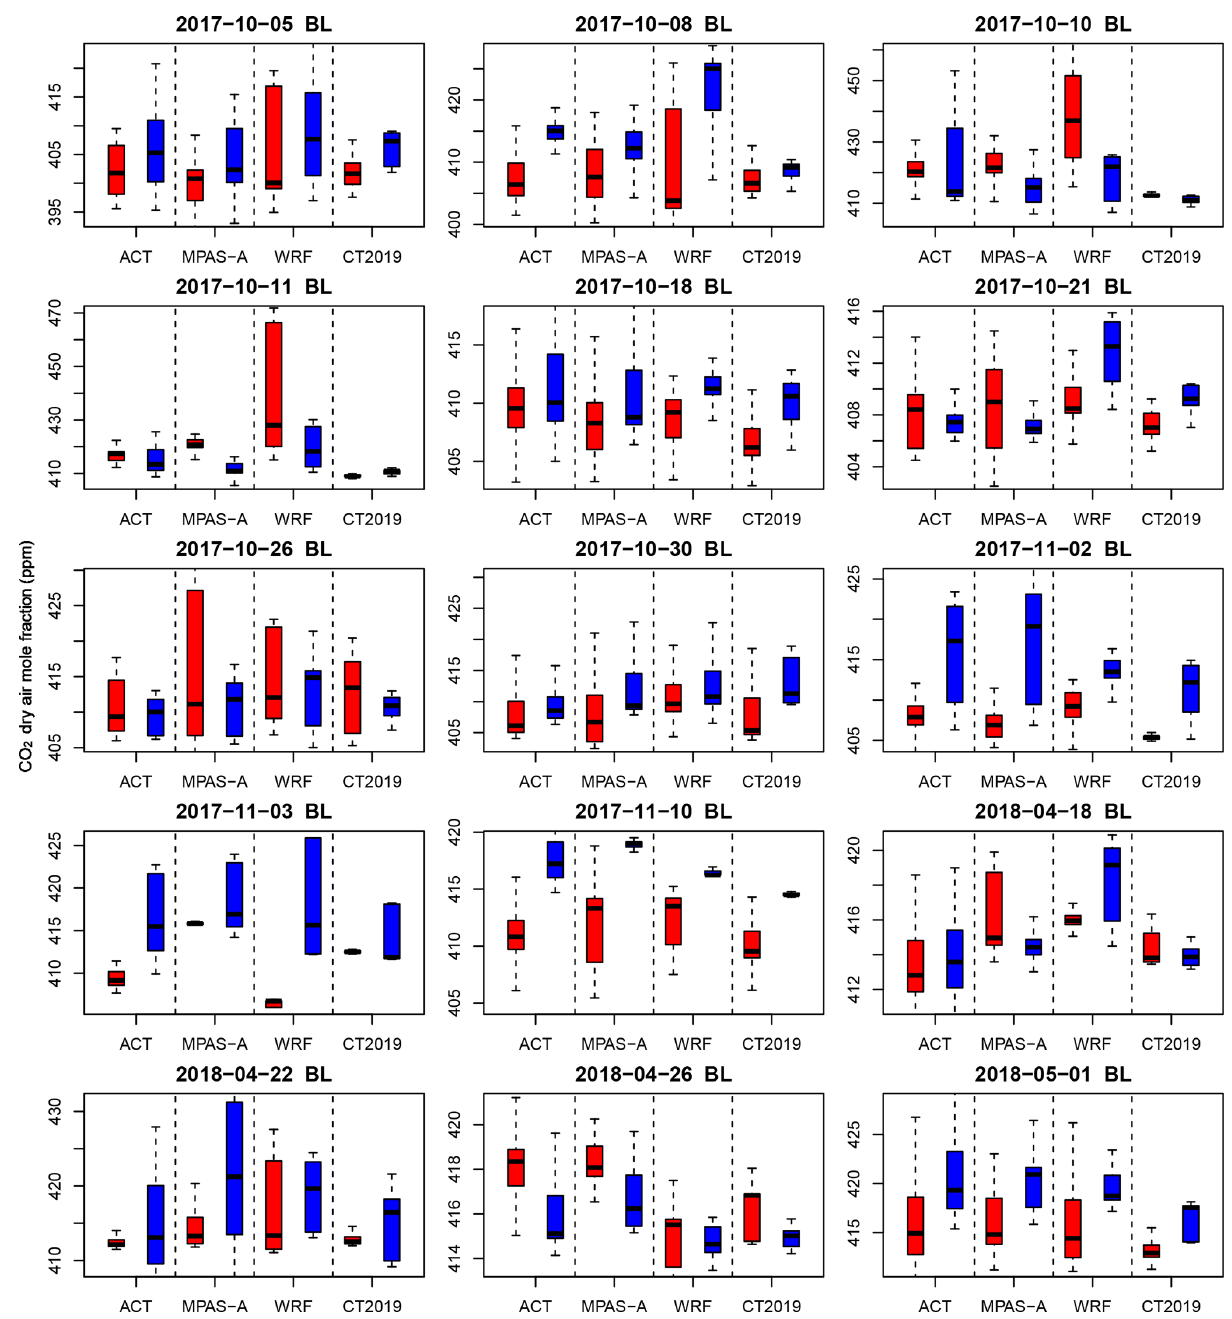
while CT2019 resulted in a 15.3 ppm difference. The above evaluation indicates that the MPAS-A CO 2 model is capable of well representing the observed CO 2 difference between the warm and cold sectors, and its accuracy in this respect is comparable to WRF-Chem and